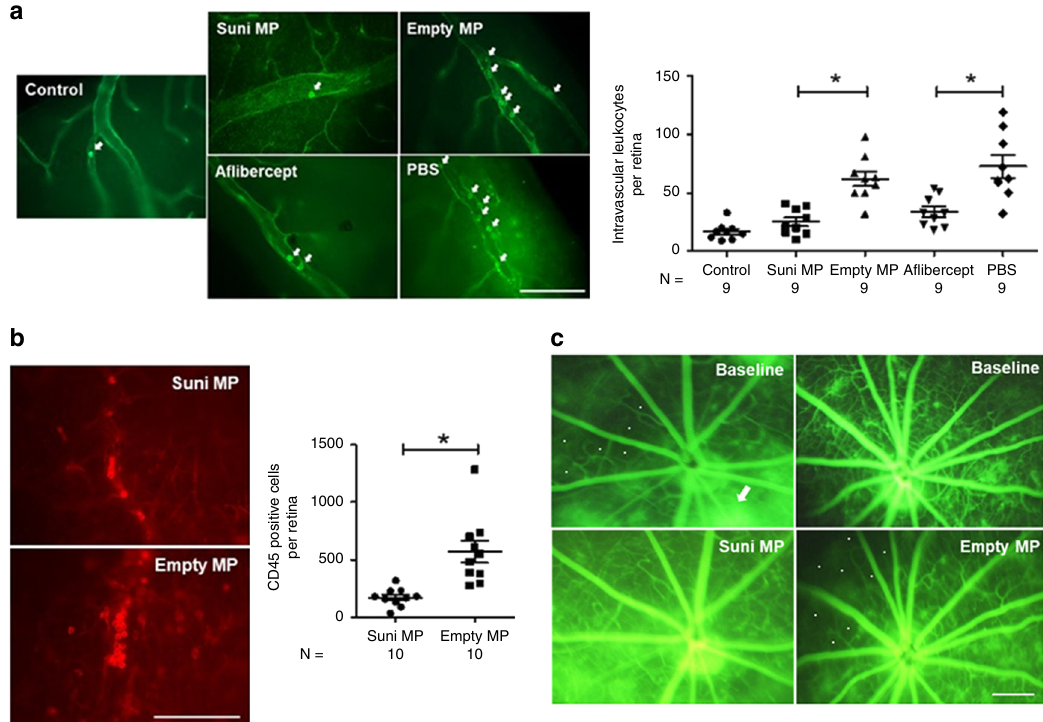
Fig. 6 Sunitinib MP reduce leukostasis and improve retinal perfusion in rho/VEGF mice. Rho/VEGF mice were given an intravitreous injection of 10 µ g of Suni MP or 40 µ g of a fl ibercept in one eye and 10 µ g of Empty MP or PBS in the other eye. After 1 week, mice were perfused through the left ventricle with PBS to remove erythrocytes and leukocytes and then perfused with FITC-concanavalin A. Examination of retinal fl at mounts by fl uorescence microscopy showed a signi fi cant reduction in mean number of adherent intravascular leukocytes per retina in Suni MP-injected eyes compared with Empty MP-injected fellow eyes and in a fl ibercept-injected eyes compared with PBS-injected fellow eyes ( a scale bar = 100 µ m; * p < 0.001 by Mann Whitney for difference from corresponding control). The experiment was repeated but leukostasis was visualized by immunohistochemical staining with anti-CD45 which showed a signi fi cant reduction in leukocytes within retinal vessels in eyes injected with Suni MPs vs. those injected with empty MPs ( b scale bar = 100 µ m; * p < 0.001 by Mann Whitney for difference from corresponding fellow eye control). Rho/VEGF mice had fl uorescein angiography at baseline and then were given an intravitreous injection of 10 µ g of Suni MP in one eye and 10 µ g of Empty MP in the other eye. Some areas of retinal nonperfusion at baseline showed improved perfusion 1 week after injection of Suni MP, but this was not seen in Empty MP-injected eyes ( c scale bar = 250 µ m). Source data are provided as a Source Data fi